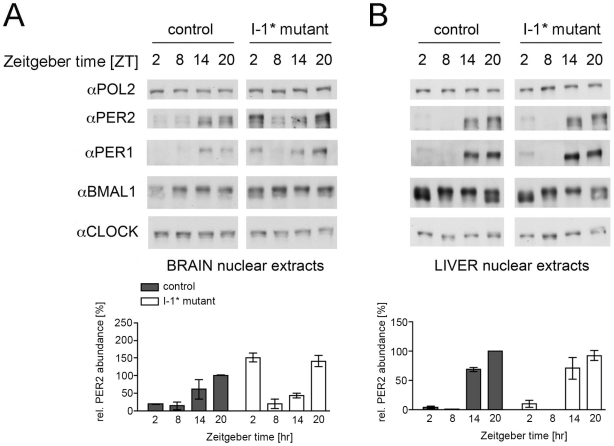
Protein expression in nuclear extracts from brain and liver.Nuclear extracts from coronal brain slices containing the SCN (A; pool of two animals) and liver (B) from control and I-1* mutant mice under on dox conditions were prepared at 6-h intervals from mice held in a 12-h light/12-h dark cycle (LD 12∶12 h cycle). The protein accumulation patterns were analyzed by Western blot analysis using the indicated antibodies. The accumulation of RNA polymerase II (antiPOL2) is shown as loading control. Below the quantification of PER2 levels in nuclear extracts from brain and liver is shown (n = 4 animals; t-test control vs. mutant at ZT2 and ZT20, p<0.05 for brain, p>0.05 for liver).